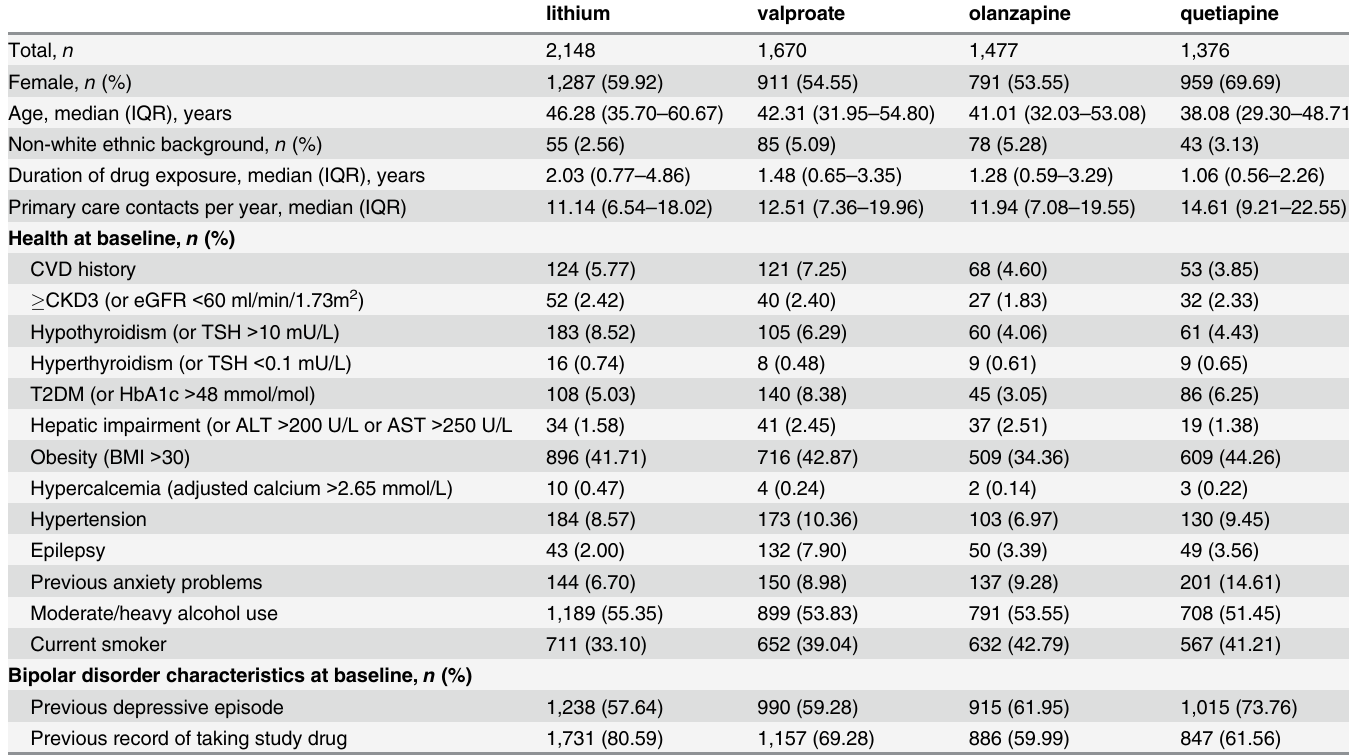
Table 1. Patient